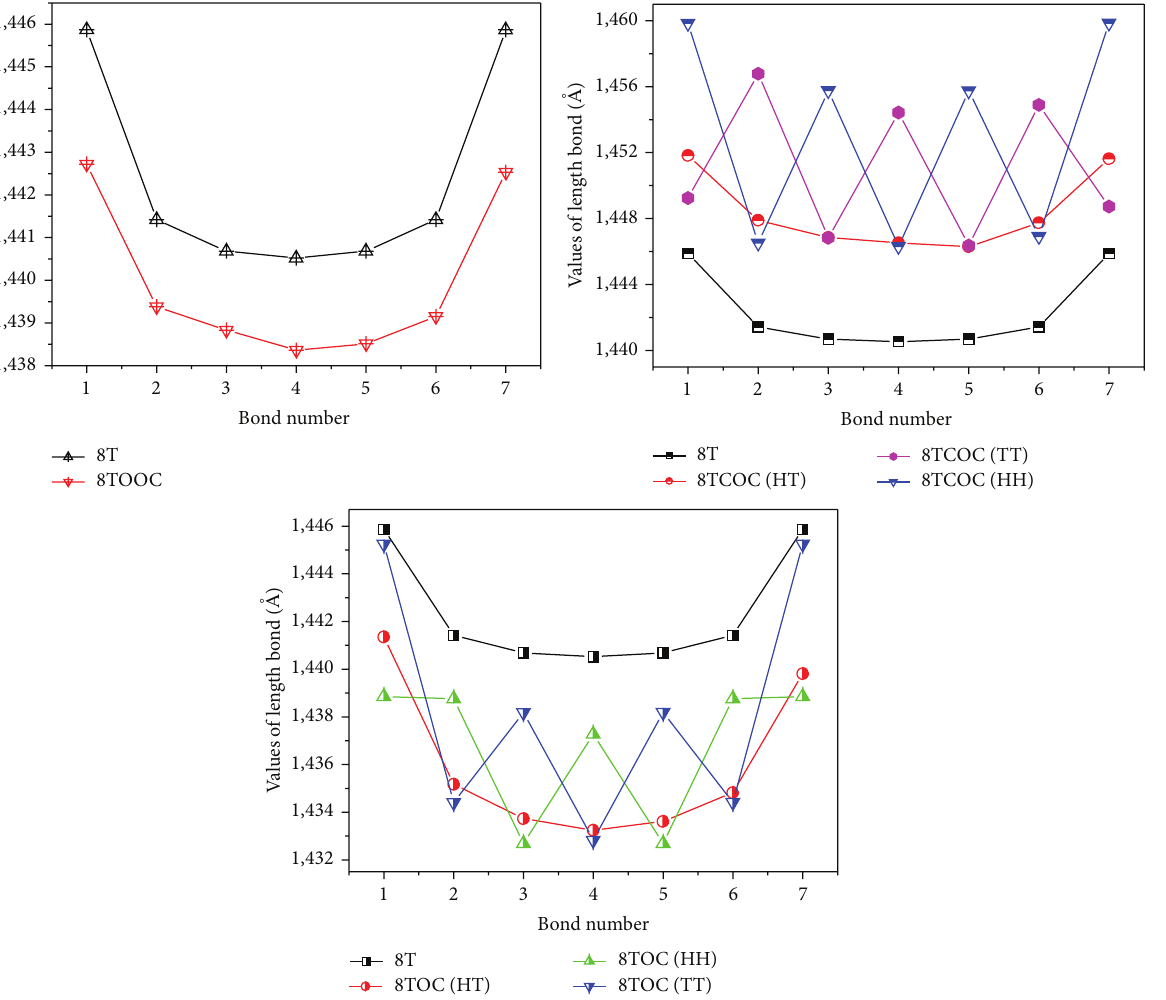
Figure 2: Optimized C-C bond lengths interring of 8T, 8TOOC, 8TCOC (HH, HT, and TT), and 8TOC (HH, HT, and TT) in neutral states with the number of bonds, studied by B3LY/6-31G(d,p) level. Table 3: Energy values of 𝐸